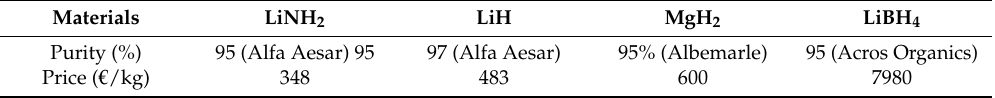
Table 2. Commercial prices of materials involved in the preparation of the metal amides-based